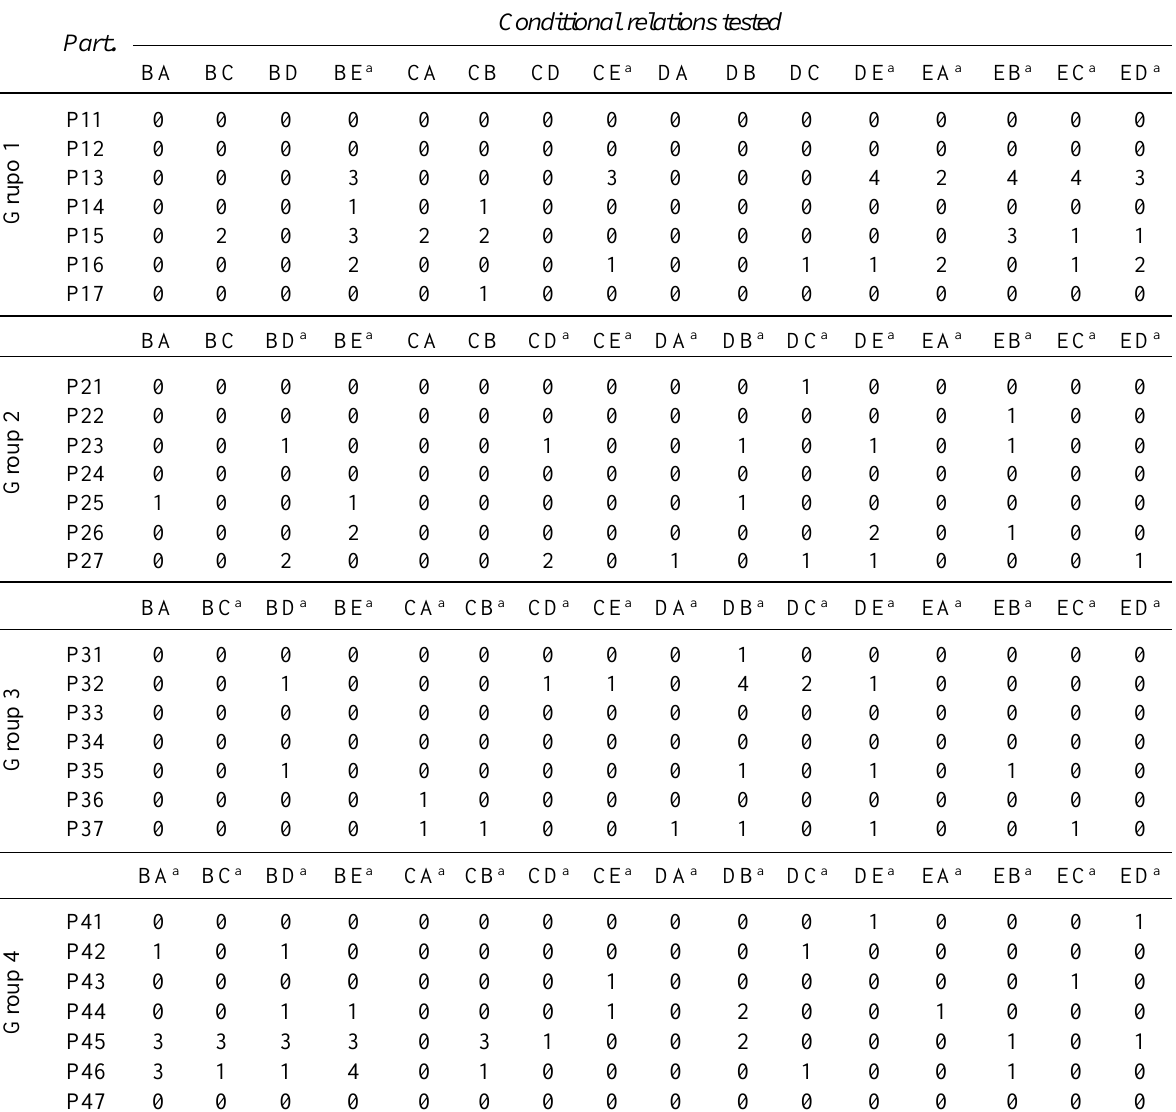
Number of Incorrect Responses by Choosing the Stimuli on Symmetry and Equivalence Conditional Relations of the First Reorganization